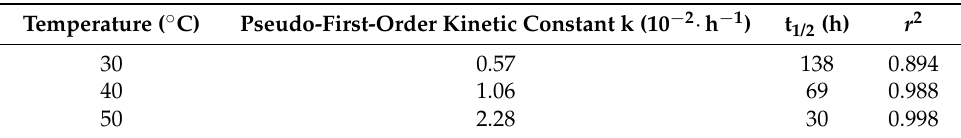
Table 1. Pseudo-first-order kinetic constant (k) of PFOA degradation by activated persulfate